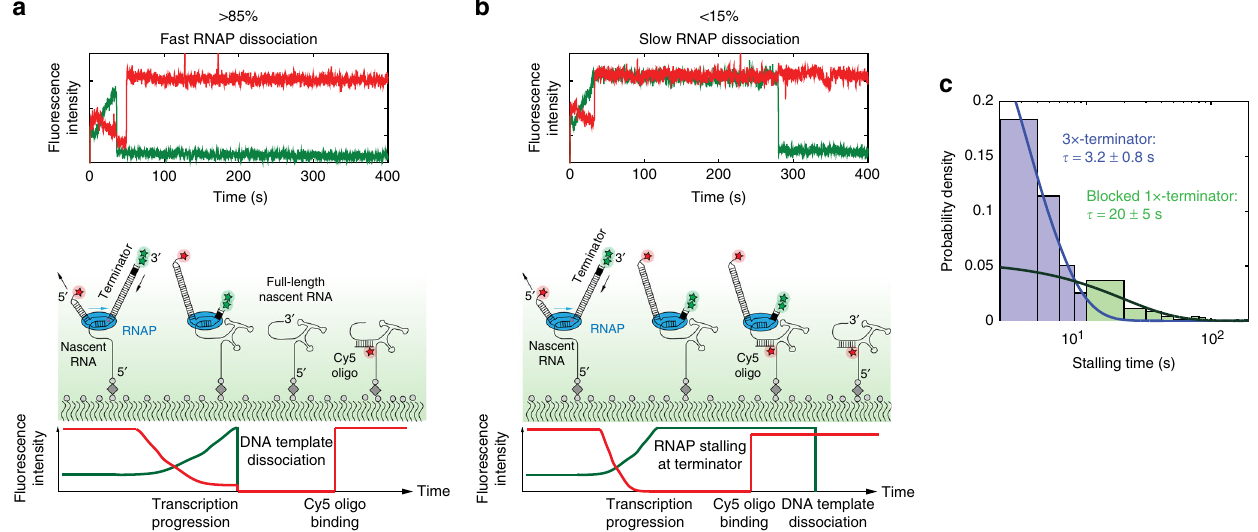
Fig. 4 RNA polymerase stalling. a , b Representative single-molecule traces (top) and corresponding molecular events (bottom) for fast ( a ) and slow ( b ) RNAP dissociation. 532 nm and 642nm lasers were used to excite the Cy3 (green) and Cy5 (red) dyes, respectively. c Residence times of the polymerase at the 3 ’ -end of the DNA template before dissociation depends on the identity of the 3 ′ -end. Only residence times < 100 s were used for fi tting to a single exponential function and the stalling time is shown in log-scale. Number of molecules analyzed ( n ) = 79 and 71 for 3 × -terminator and blocked 1 × - terminator, respectively. Constructs and histograms in linear scale are shown in Supplementary Fig. 3. Source data are provided as a Source Data fi le